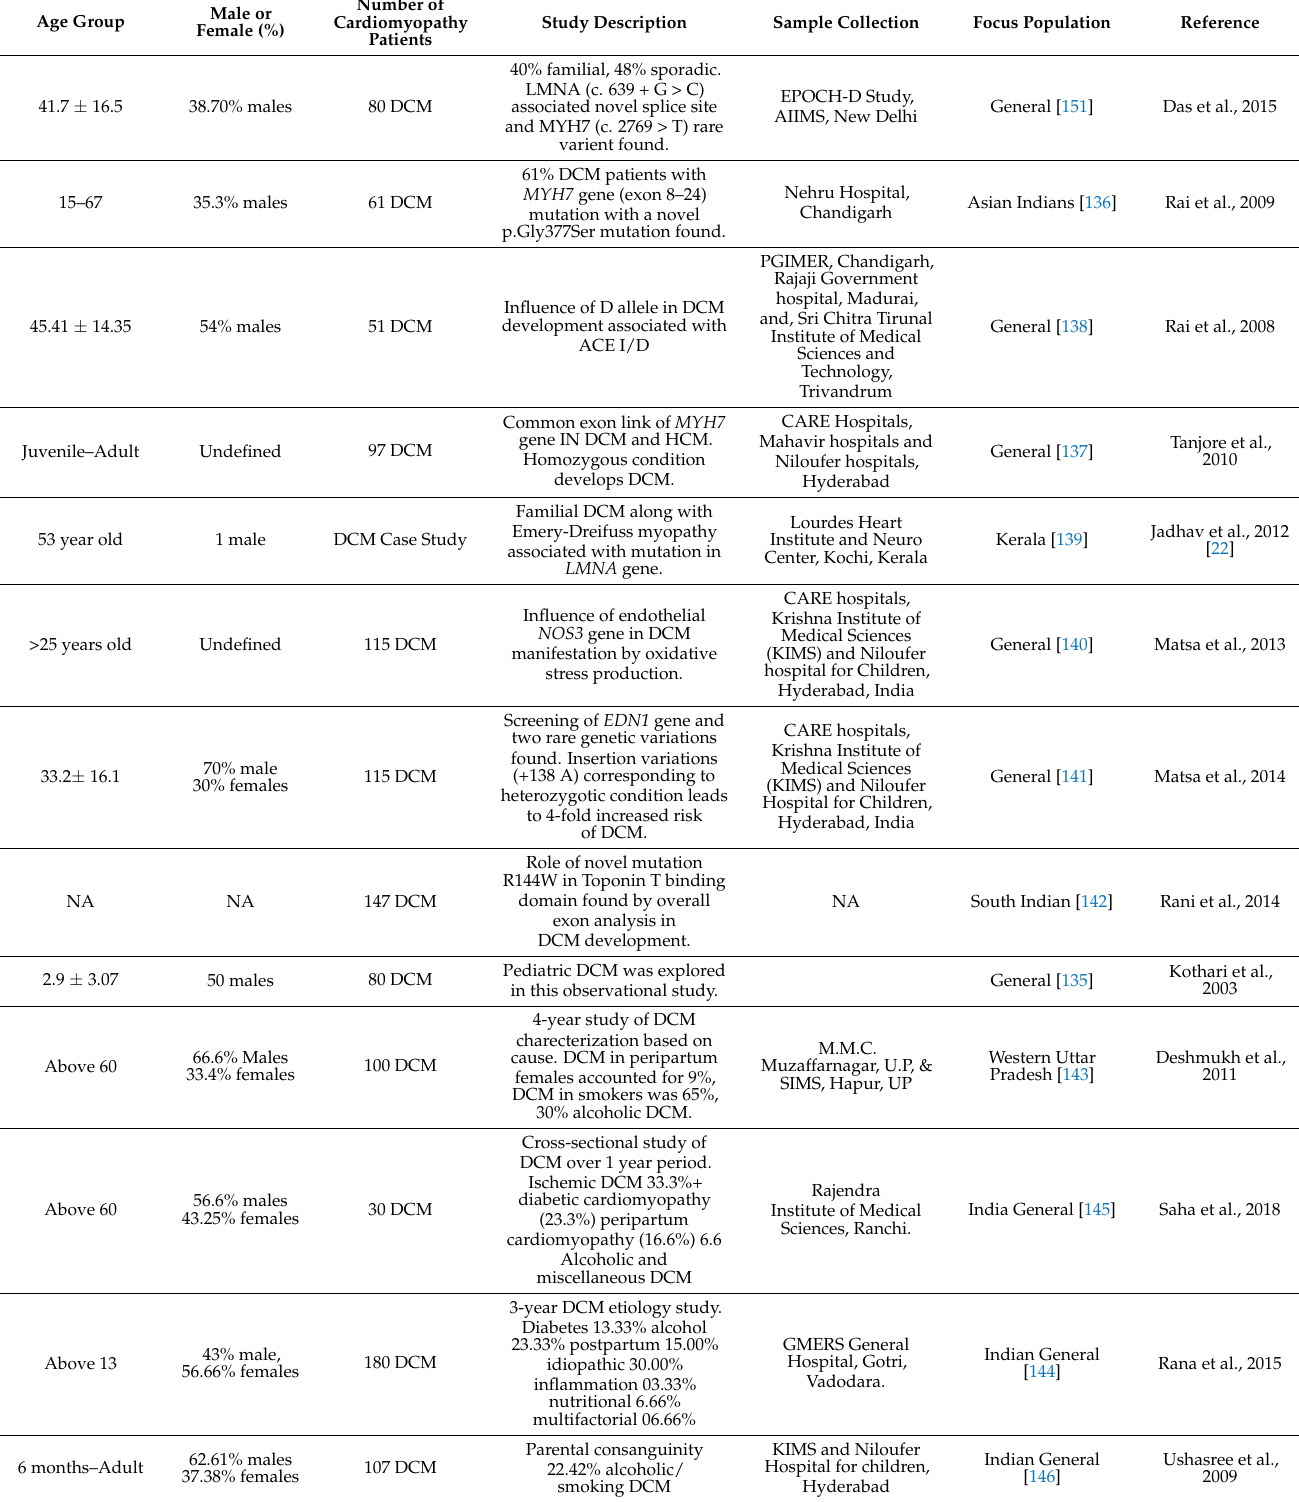
Table 6. Summary of DCM studies performed across different states of